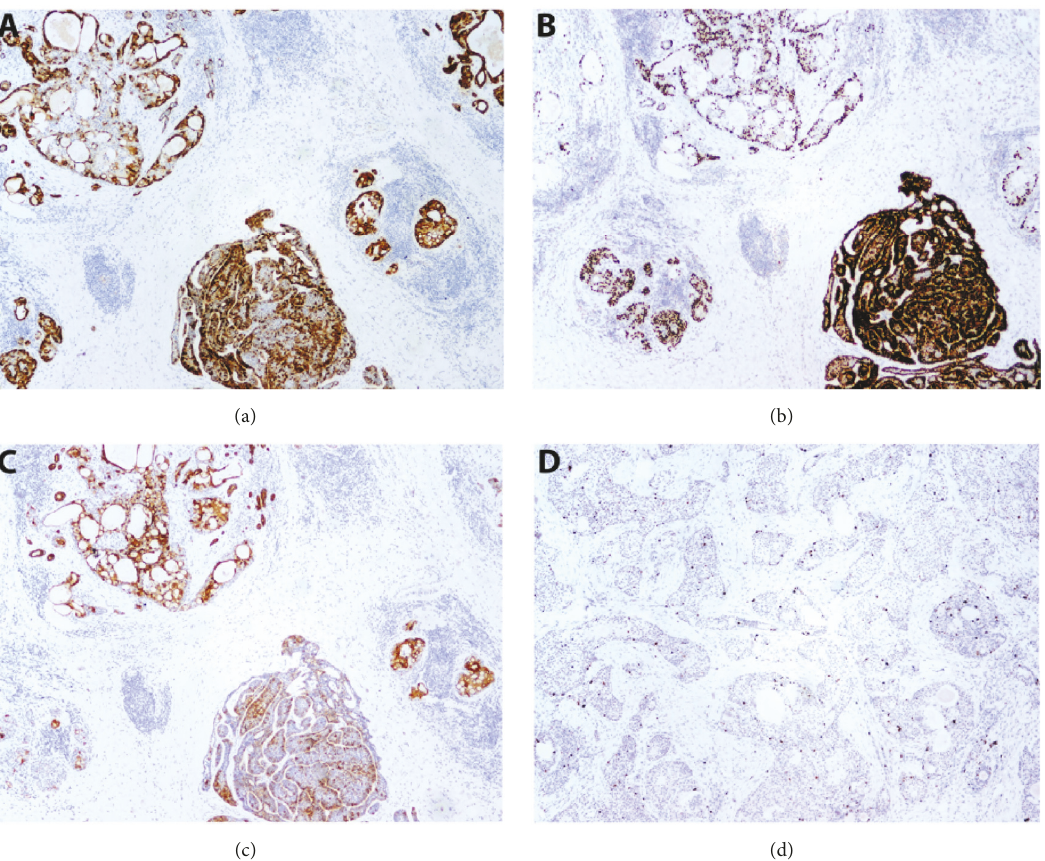
Figure 2: Immunohistochemical findings of the parotid gland mass. (a) A CK5/6 stain highlights the peripheral abluminal squamoid cells in mucoepidermoid carcinoma (upper left) as well as a prominent abluminal myoepithelial cell population in the basal cell adenoma (lower middle). (b) Similarly, p63 shows peripheral positivity in both tumor components. (c) A stain for CK7 highlights mucocytes and cells adjacent to glandular lumens in the mucoepidermoid carcinoma and patchy cells throughout the basal cell adenoma with a subset of luminal cells staining intensely. (d) The proliferation index as estimated by an immunohistochemical stain for Ki-67 is approximately 3-4% in the mucoepidermoid carcinoma; the basal cell adenoma is no longer present in the deeper level used for